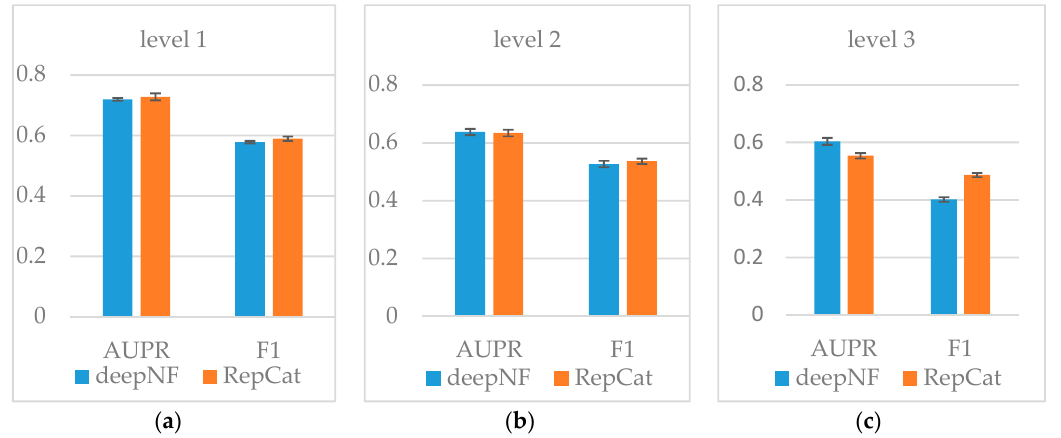
Figure 7 . Performance comparison on yeast dataset between ReprsentConcat and deepNF: ( a ) Level 1; ( b ) Level 2; and ( c ) Level 3.